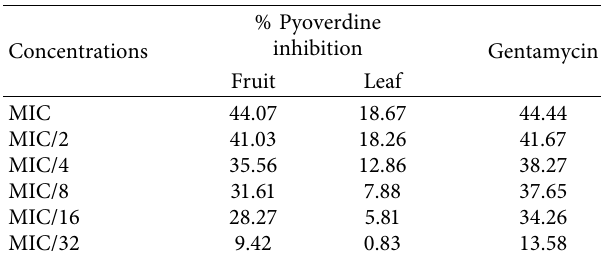
Table 6: Inhibition of bioflm formation in P. aeruginosa by leaf and fruit essential oils of Vitex doniana .